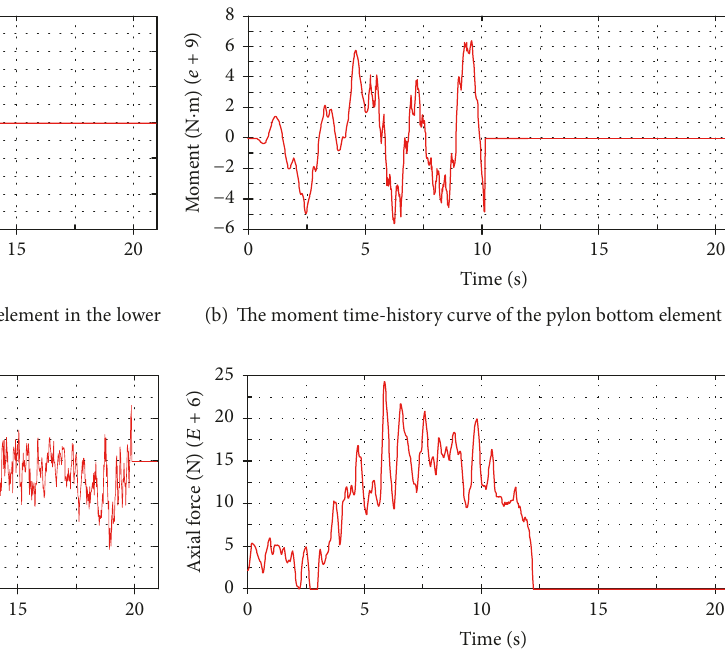
(d) The axial force time-history curve of FS01 cable element